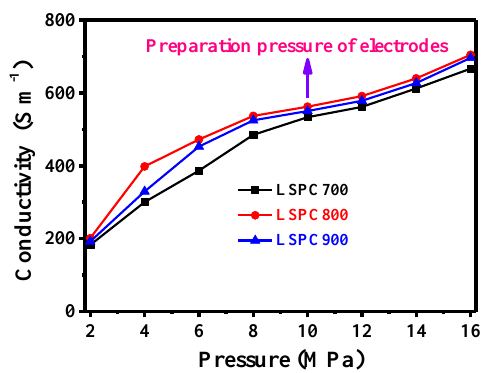
Figure 6. The electrical conductivity of LSPCs under the pressure ranging 2 to 16 MPa.